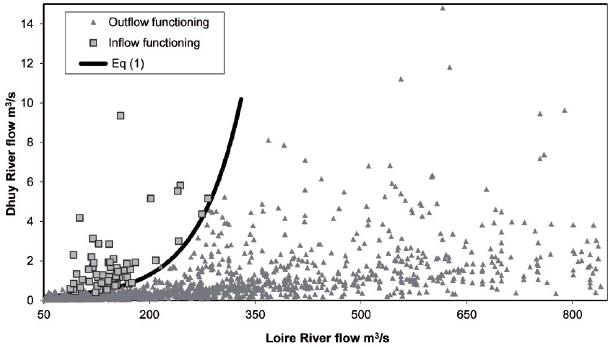
Fig. 2. Average daily Dhuy river flow versus the Loire river flow at Orl´eans between 1 June 1997 and 31 December 2001, with an in- dication of the outflow (triangles) and inflow (squares) functioning of the karstic Bouillon Spring. Note: only Loire river flows below 850m 3 s − 1 are